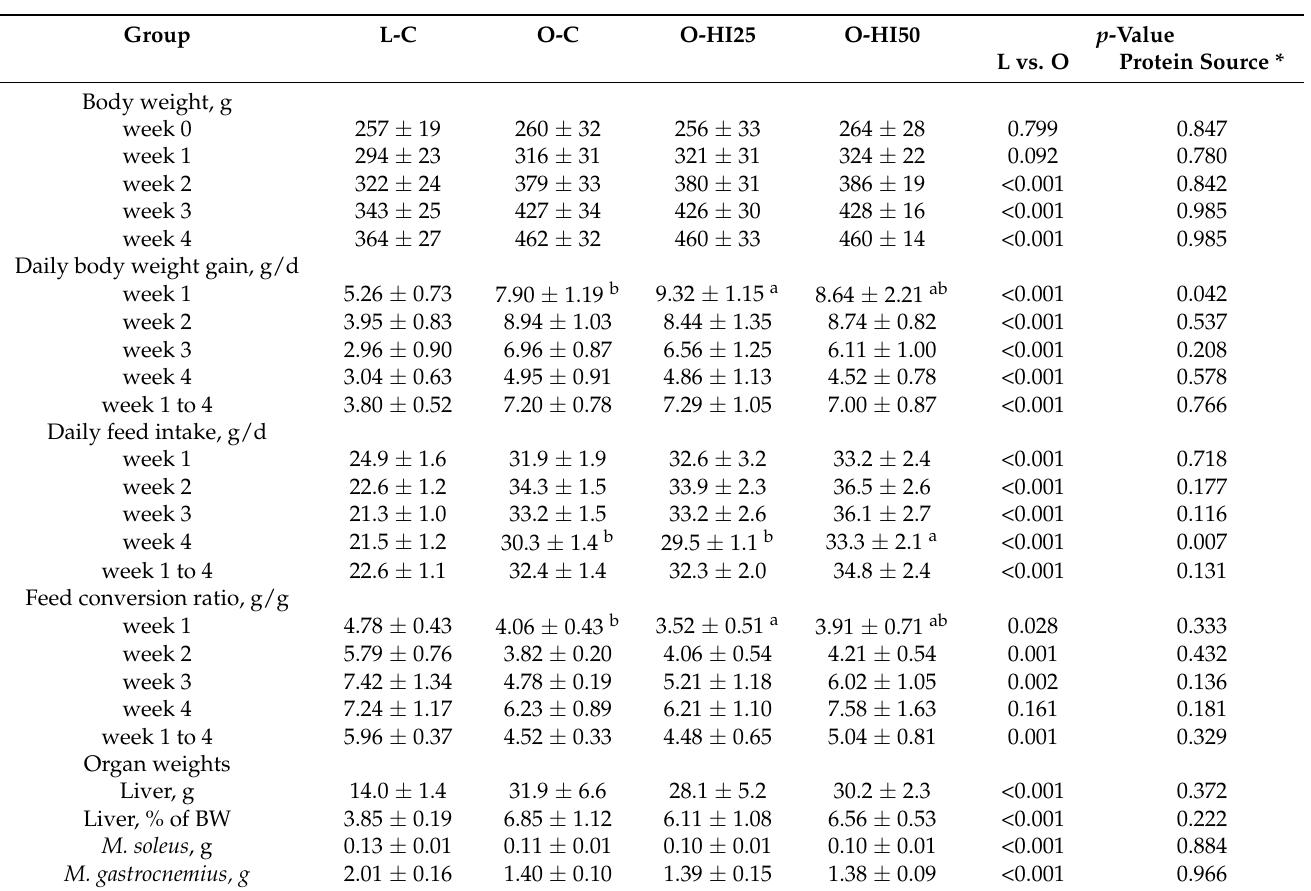
Table 4. Performance and organ weights of lean rats fed a control diet with casein (L-C) and obese rats fed either the control diet with casein (O-C) or the control diet in which 25% (O-HI25) and 50% (O-HI50) of the protein from casein was replaced with protein from HI larvae meal for 4 weeks.